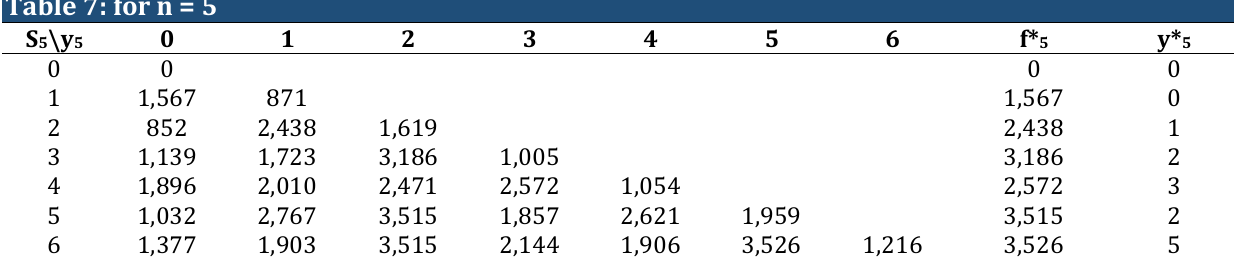
Table 7: for n = 5 S 5 \y